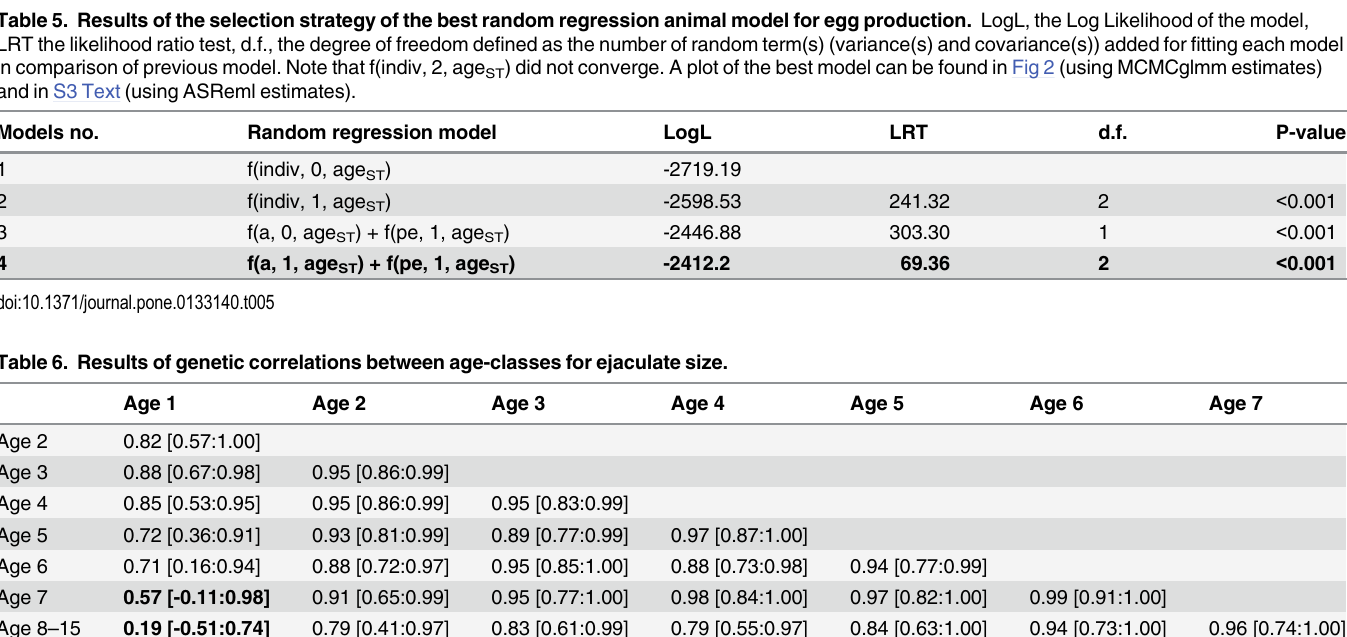
Genetic correlations in bold were not signi fi cantly different from 0.